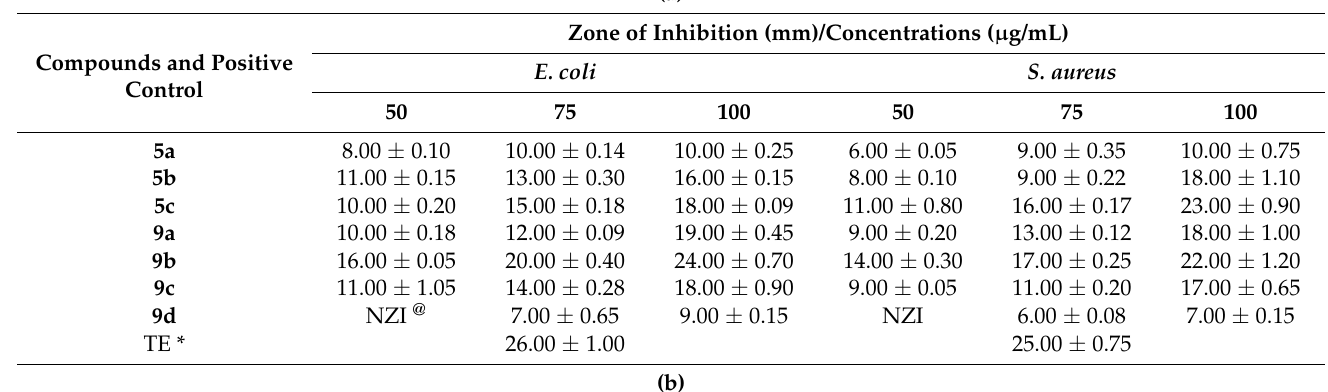
Table 4. ( a ) Zone of inhibition of compounds 5a – c and 9a – d against bacterial pathogens. ( b ) Zone of inhibition of compounds 5a – c and 9a – d against fungal pathogens.